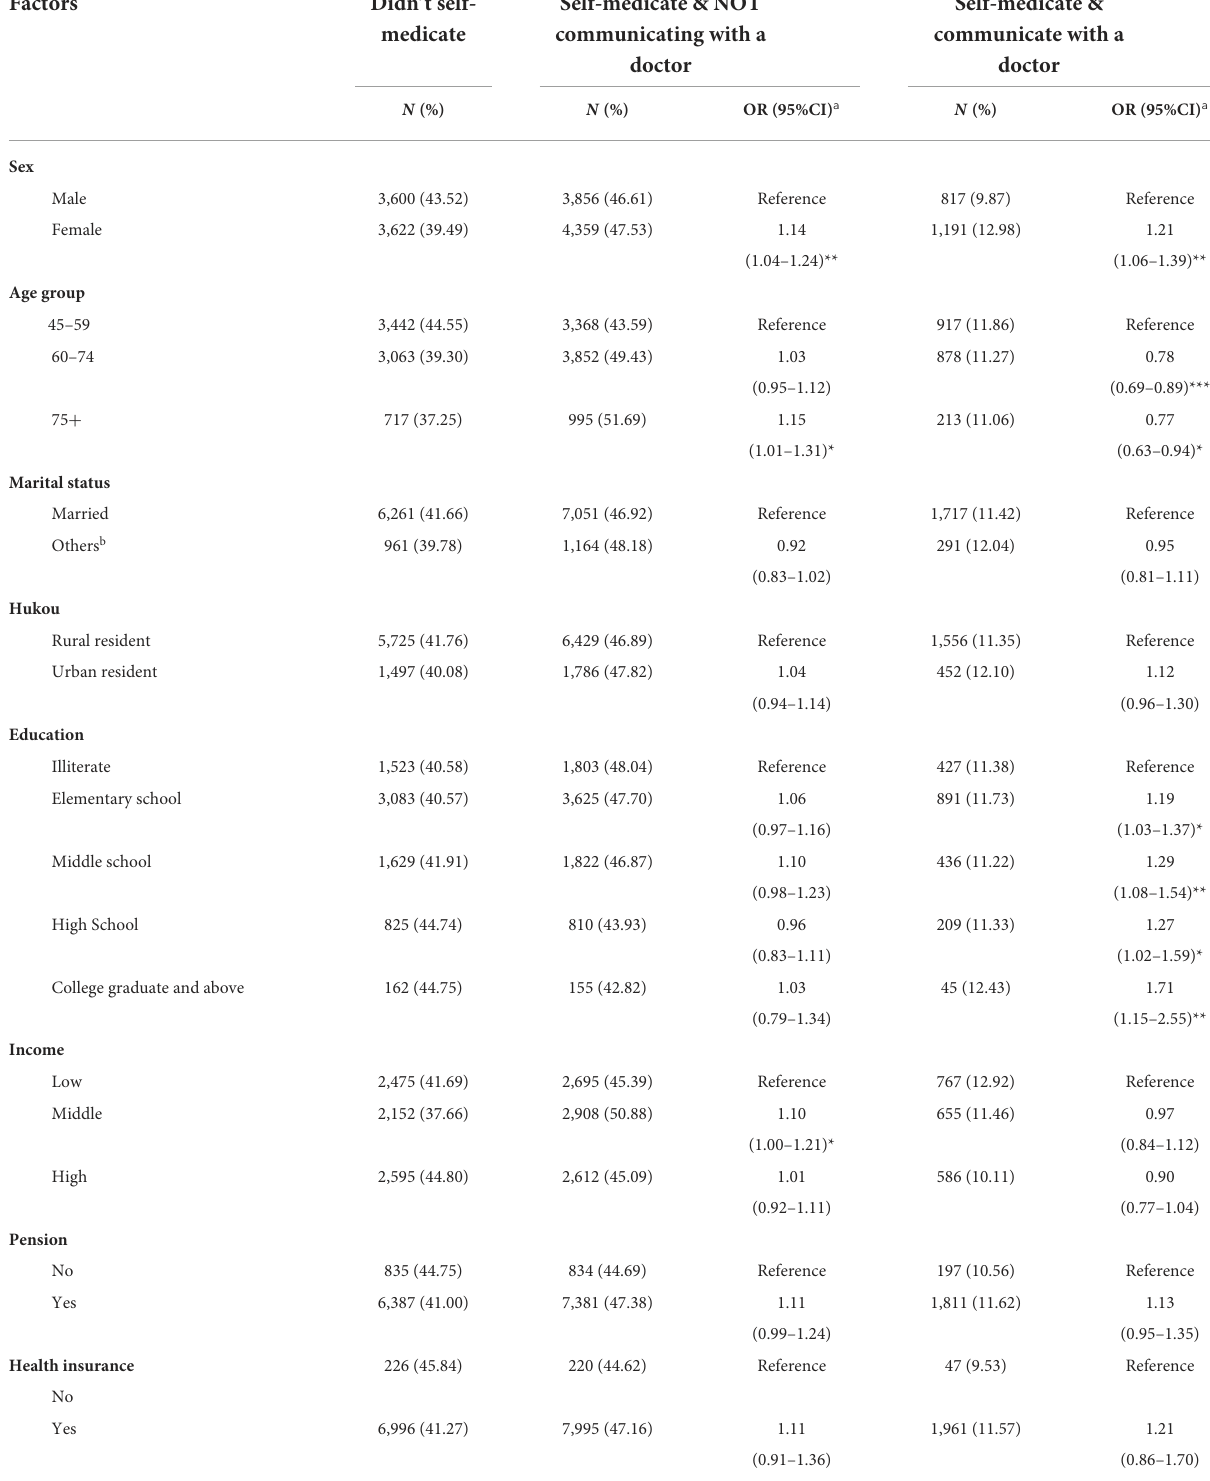
TABLE 2 Multinomial logistic regression model for influencing factors of self-medication and doctor communication among elder Chinese, 2018 (reference category is the group who didn’t